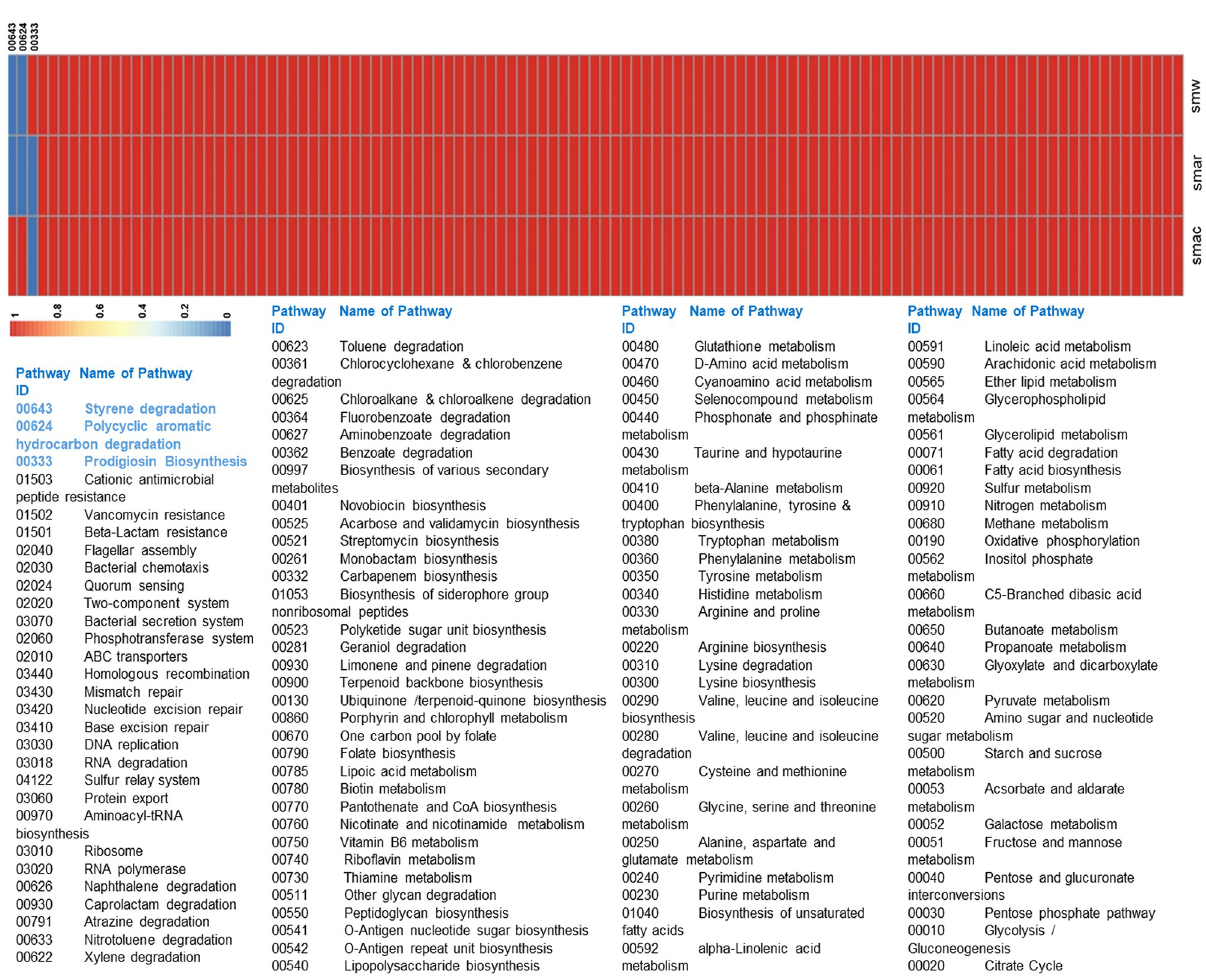
Fig 2. Heatmap showing the metabolic pathways in three strains of bacteria. Blue represents absence and brick-red represents presence of a pathway. The ids for the first three pathways have been provided in the heatmap with the remaining ids provided in the key. The unique pathways have been highlighted in blue in the key. The strains are denoted as smw (WW4), smar (SM39) and smac (Db11) strains according to Kyoto Encyclopedia of Genes and Genome